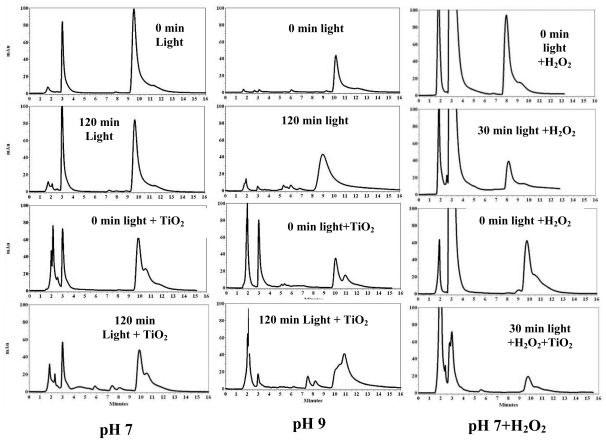
HPLC chromatogram of 3,4′,5-trichlorobiphenyl (9.8 ± 0.2 min) irradiated at pH 7 or 9 in the presence or absence of H2O2.